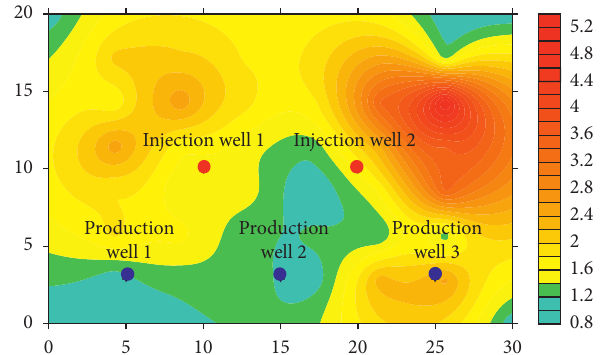
Figure 12: Field diagram of the dilution multiple after the chemical agent injection of 0.6PV with strong edge